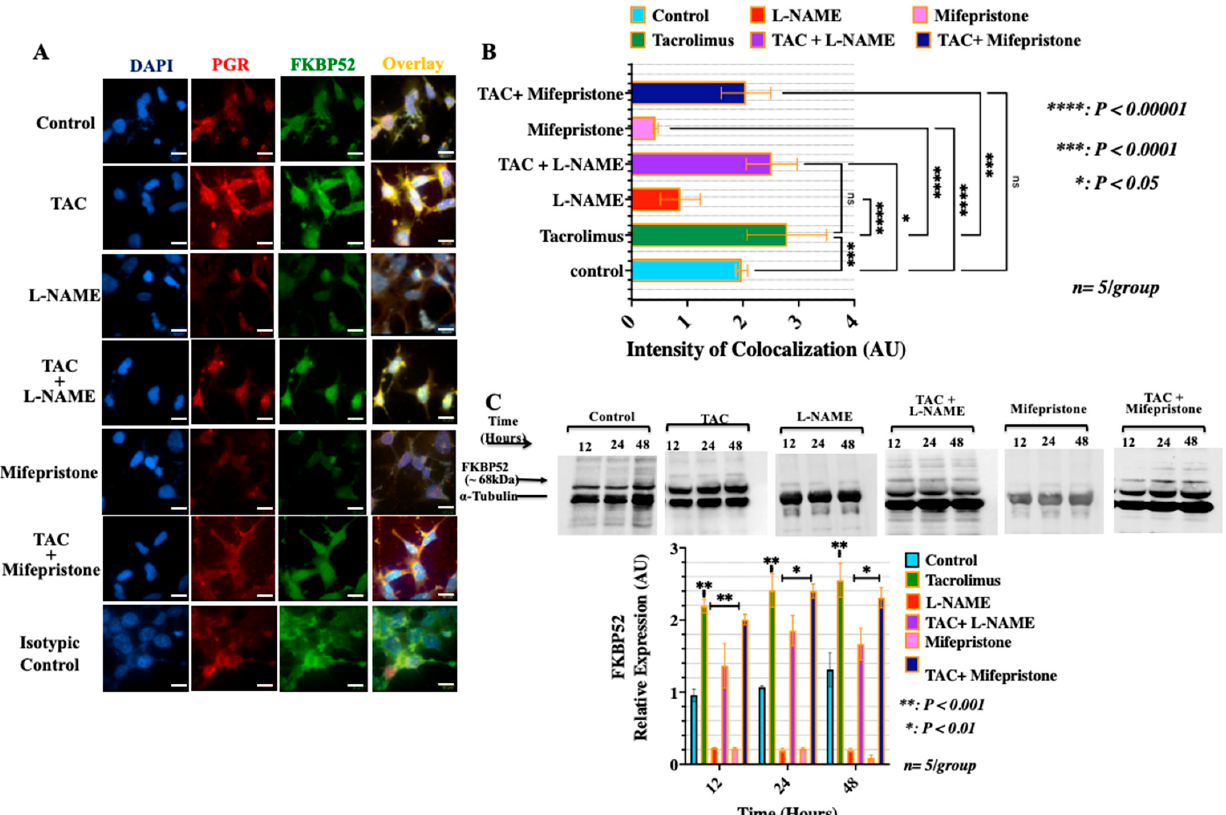
Figure 4. Effect of low-dose tacrolimus, L-NAME or mifepristone and their combination formula- tions on the levels of expression and cellular localization of FKBP52 and PGR in HTR-8/SVneo cells. ( A ) Representative confocal fluorescent microscope images of monolayers of confluent HTR-8/SVneo cells treated for 24 h with low-dose tacrolimus (10 ng/mL), L-NAME or a combination of both. Cells were stained with antibodies to PGR (red channel) and FKBP52 (green channel) and cell images were captured and analyzed for their fluorescent intensity using Quorum Wave Effects Spin- ning disc confocal microscope. Nuclei were counterstained with DAPI (blue channel) and the colo- calization of PGR and FKBP52 appears as yellow on the overlay images. ( B ) Histogram depicting differences in the intensity of colocalization of PGR and FKBP52 (yellow channel) showing signifi- cant effect of low-dose tacrolimus on the expression of the PGR-FKBP52 complex in treated HTR- 8/SVneo cells. ( C ) Representative WB images and associated histograms of the expression levels of FKBP52 protein in the tacrolimus- and L-NAME-treated HTR-8/SVneo cells. Note the statistically significant effects ( p < 0.001) of tacrolimus in antagonizing the suppressive actions of L-NAME and those of mifepristone on the protein expression of FKBP52 in the HTR-8/SVneo cells. Data in ( B ) and ( C ) are represented as the mean with error bars representing S.D. Scale bars in A = 15 μ m. Mifepris- tone was used to determine the mode of action of tacrolimus in potentiating the PGR signaling in HTR-8/SVneo cells. 3.4. Treatment with Low-Dose Tacrolimus Rescued the Production of NO in HTR-8/SVneo Cells in the Presence of L-NAME Trophoblast production of NO is a recognized contributor of uterine proper spiral artery remodeling during early pregnancy [9]. To examine the effect of low-dose tacroli- mus on NO production in HTR-8/SVneo cells, cells treated under the different experi- mental conditions were collected after 24 h and subjected to flow cytometry analysis and fluorescent staining. The right shifted peak seen in Figure 5A indicates high mean fluo- rescence intensity for the levels of NO within these cells. Although treatment with tacro- limus alone reduced the level of NO production in the control HTR-8/SVneo cells (Figure